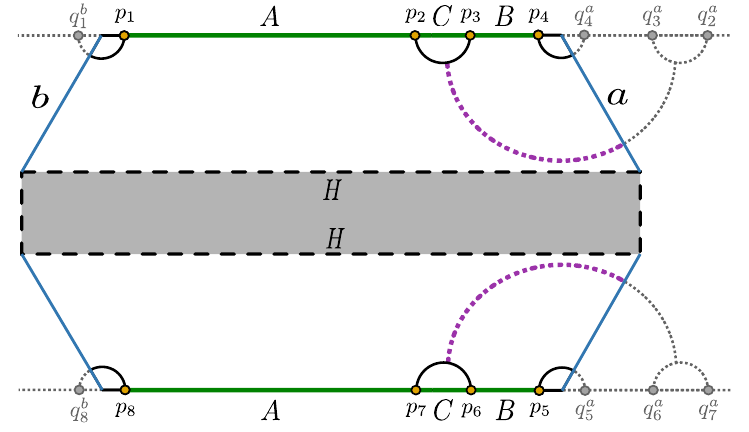
Figure 23 . The endpoints of the intervals A and B and the image points in the two BCFT 2 copies are identified similarly as in figure 20. The other points q a points of p 2 and p 3 respectively with respect to the a -boundary. Also q a the image points of p 6 and p 7 respectively with respect to the a